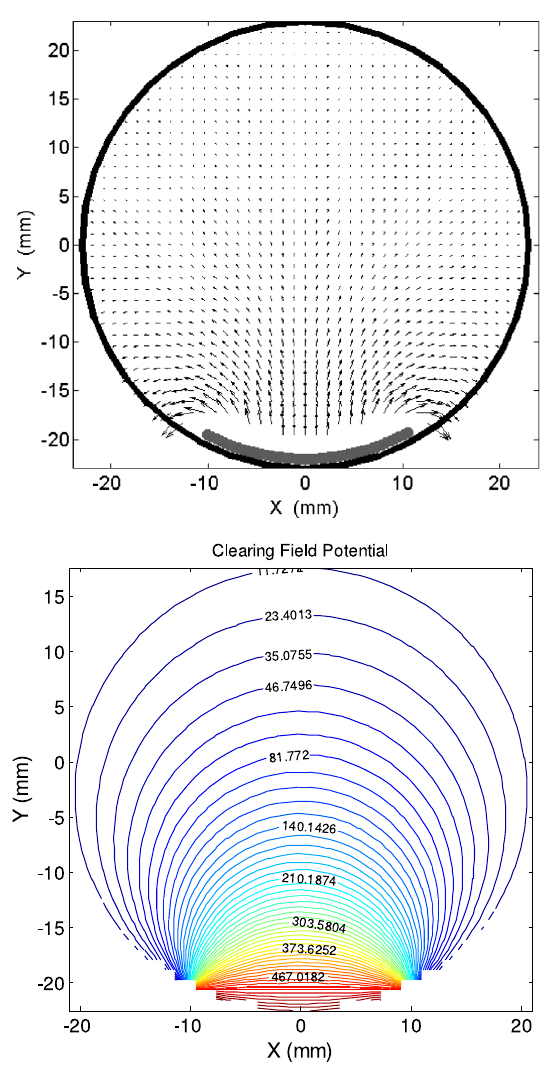
FIG. 15. Simulated EC distribution in transverse plane at the position of maximum vertical magnetic field component in the wiggler for the case of no clearing voltage.